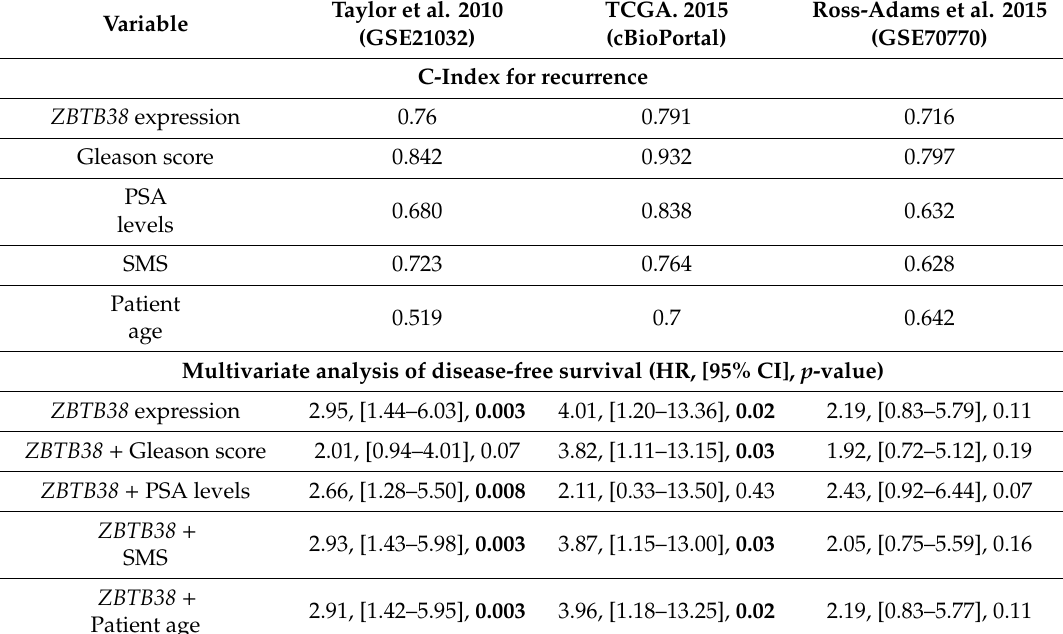
Table 3. ZBTB38 expression levels independently predict prostate cancer disease-free